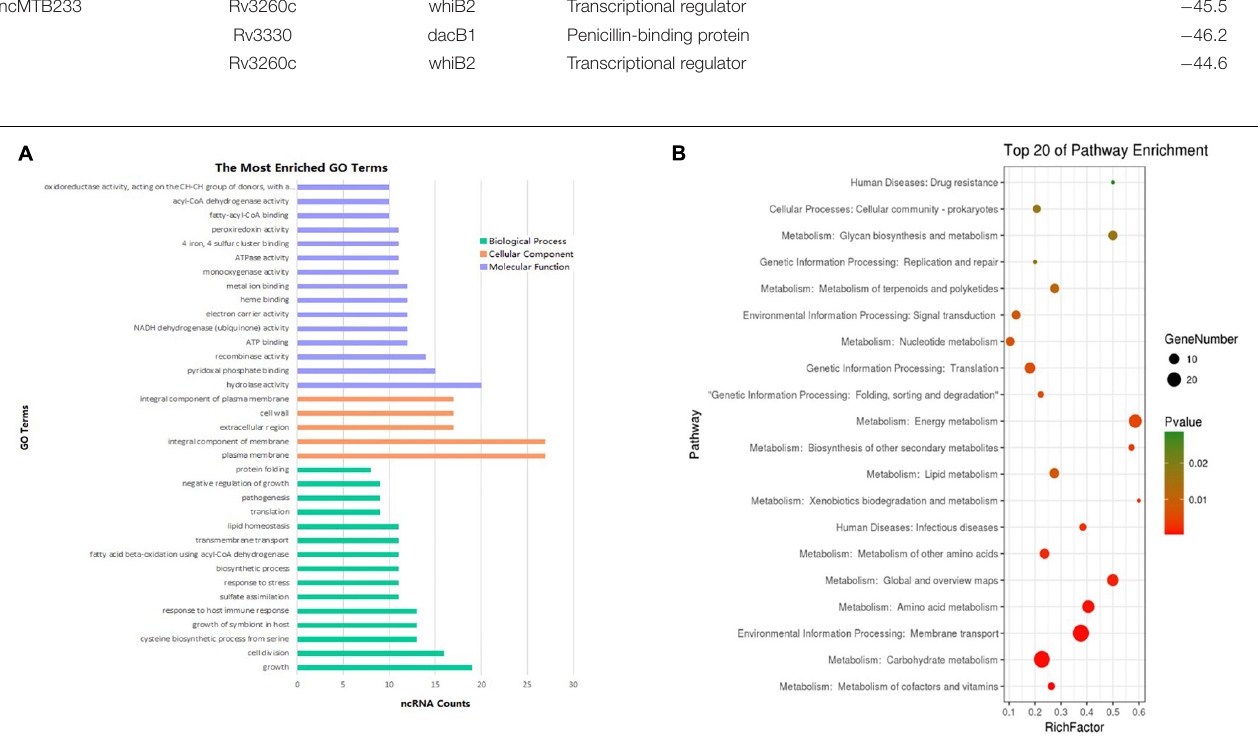
FIGURE 6 | Enrichment analysis of differentially expressed ncRNAs (| FC| > 1.5). (A) GO pathways ( p < 0.1) of the targets most enriched in biological process, cell component, and molecular function. (B) Top 20 KEGG enrichment results ( p < 0.1) of the target genes.